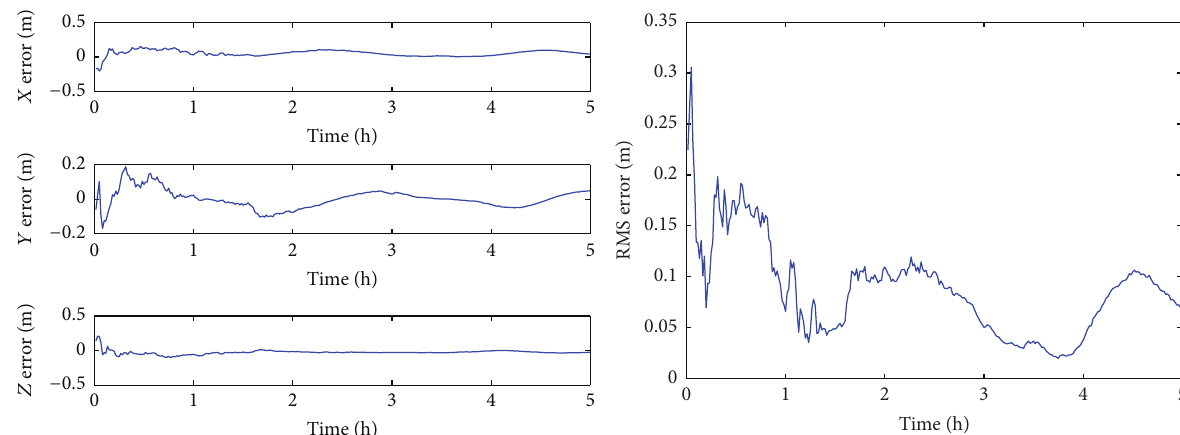
Figure 10: Error of absolute position estimation for satellite 3 using